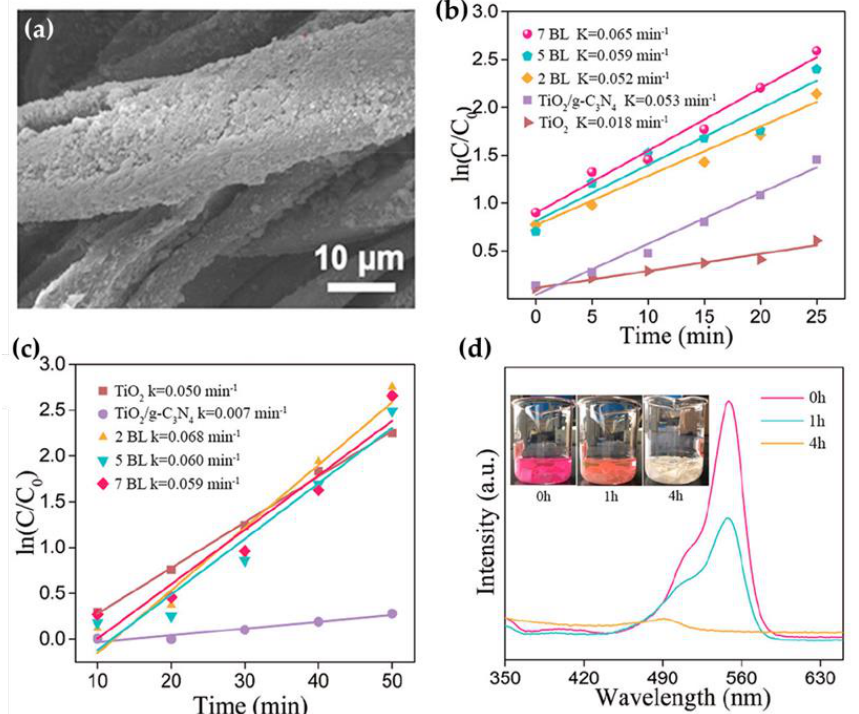
Figure 9. SEM images of the cotton modified with TiO 2 /g-C 3 N 4 ( a ); kinetic degradation curves of RhB under visible-light irradiation ( b ), kinetic degradation curves of toluene under simulated sunlight irradiation ( c ); absorption spectra of RhB under real sunlight ( d ). Reprinted with permission from [105]. Copyright 2019, ACS Publications.